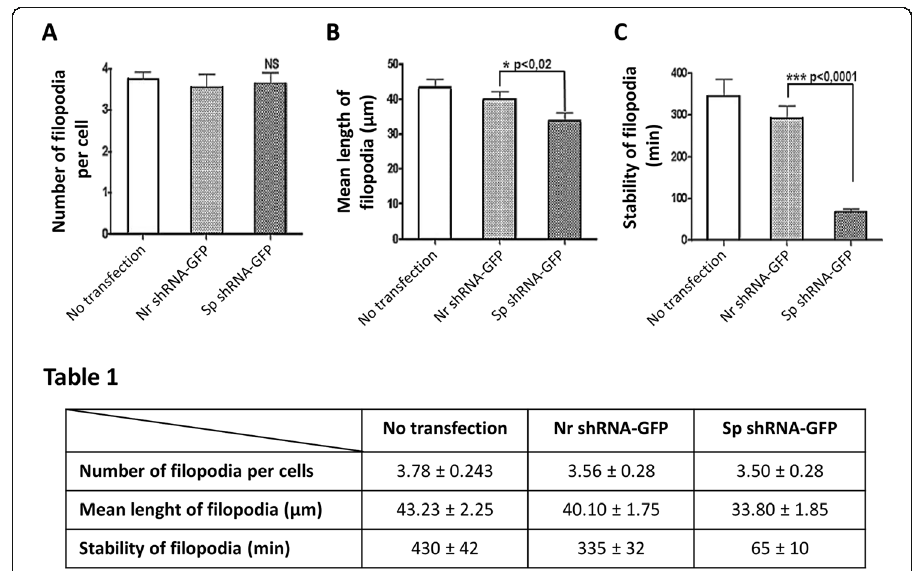
Fig. 7 Knockdown of α II-spectrin destabilizes cell projection. a through c The number of cell extensions (filopodias) and their maximum size and lifetime (stability) were evaluated in HMEC-1 cells which were transfected or not with plasmids expressing GFP and Nr shRNA or Sp shRNA. The number of filopodia per cell is not significantly affected in cells transfected with shRNA targeting α II-spectrin ( a ; Bartlett ’ s test ANOVA, p = 0.8487), but their length is significantly reduced ( b ; Bartlett ’ s test, p = 0.0076) and their lifespan is dramatically decreased ( c ; Mann Whitney test, p =